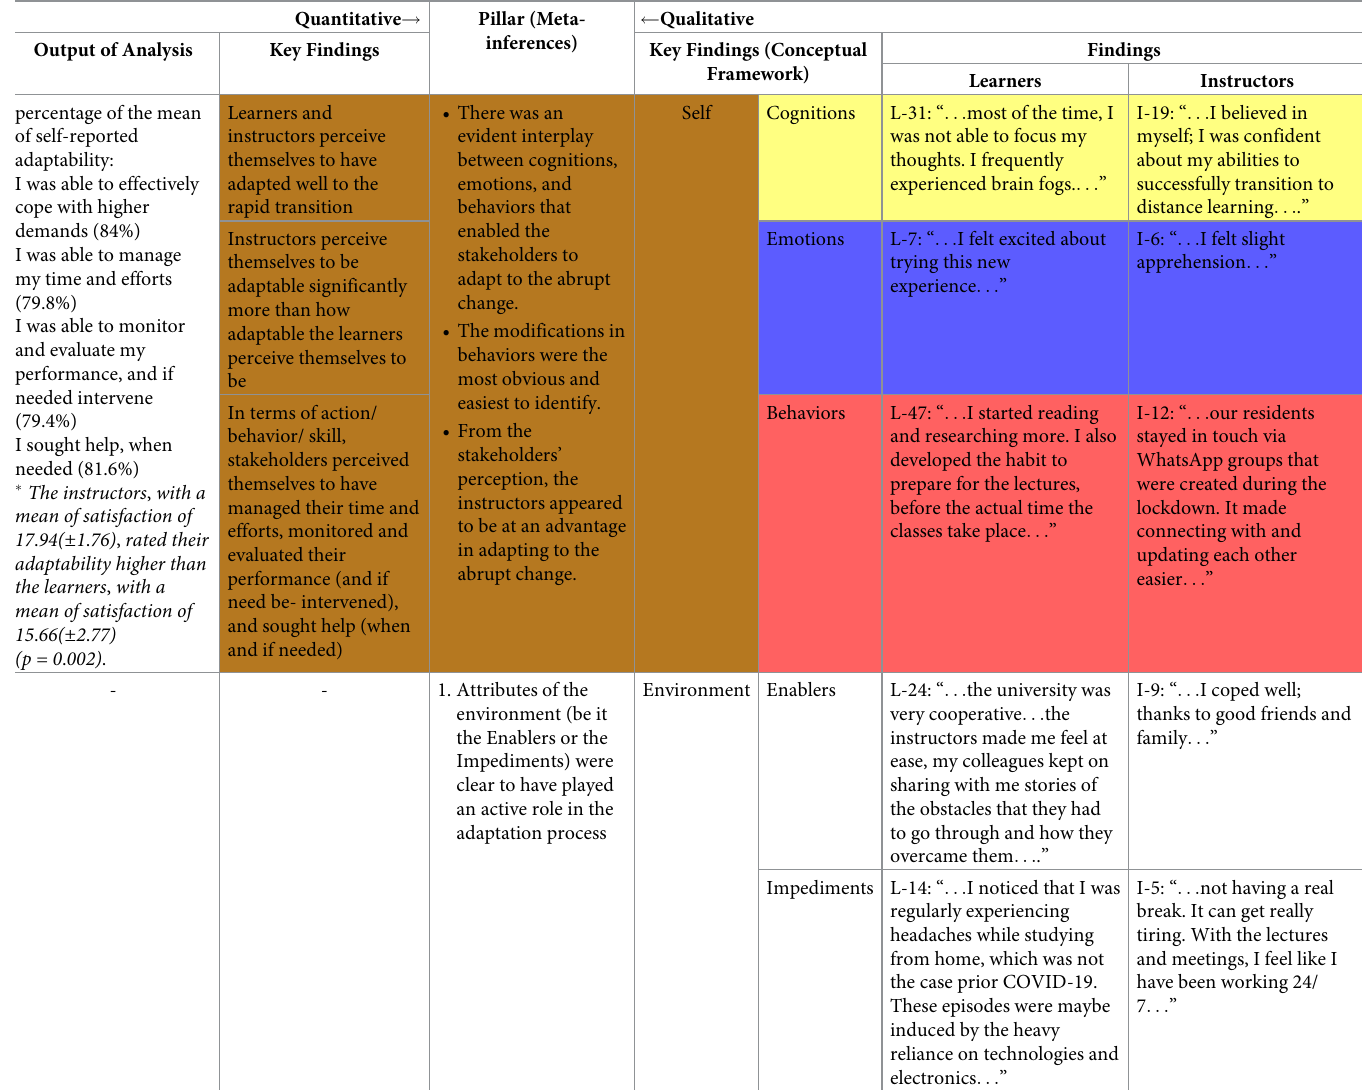
Table 2. The study’s joint display (merging of the quantitative with the quantitative output of